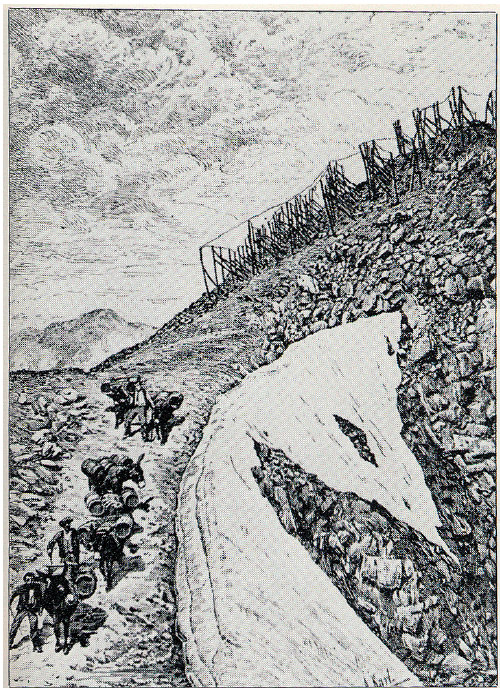
Figure 14. The apparatus of Clementine X. Vaussenat, erected on the Pic du Midi. See text. After Eather (1980, [49] p. 237).